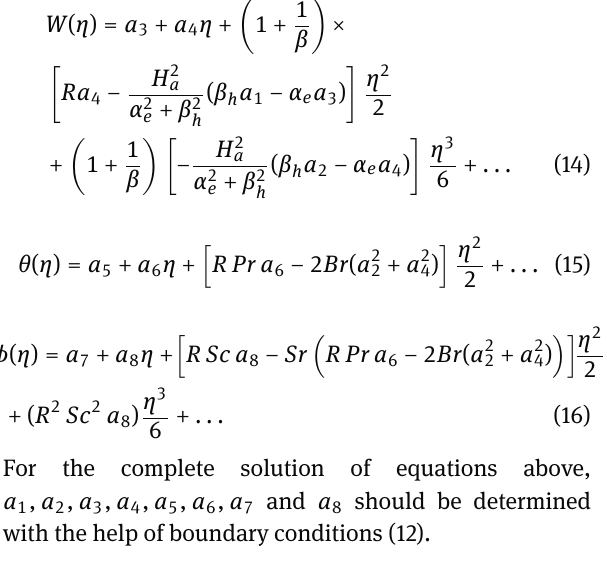
discussed in the works by Srinivasacharya and Kaladhar ([24]-[32]) and also citation therein. To ensure the convergence and the admissible values of h i , i = 1, 2, 3, 4, the h -curves are plotted for 18 th - order of approximation in Figs.2 -3 by taking the values of the parameters β = 1.0, Ha = 2.0, B = 1.0, R = 1.0, A = 1.0, Pr = 0.71, B i = 2.0, Sc = 0.22, B = 2.0, Sr = h 0.3, Br = 0.5. It is evident from Figs. 2 -3 that the h -curves have parallel line segments that corresponds to regions −0.8 < h 1 < −0.15, −0.9 < h 2 < −0.1, −1.5 < h 3 < −0.4 and −1.5 < h 4 < −0.4. To choose optimal value of auxil- iary parameter from these wide ranges, the average resid- ual errors are studied at different order of approximations ( m ), minimum of average residual errors are shown in Ta- bles 2-5. From Table 2, we see that the average residual er- ror for U is minimum at h 1 = −0.37. Table 3 shows that the minimum of average residual error for W attains at h 2 = −0.59. Table 4 depicts that at h 3 = −1.06, E at- θ tains minimum. The average value of E is minimum for ϕ h 4 = −0.83 as illustrated in Table 5. Therefore, the opti- mum values of convergence control parameters are taken as h 1 = −0.37, h 2 = −0.59, h 3 = −1.06 and h 4 = −0.83.